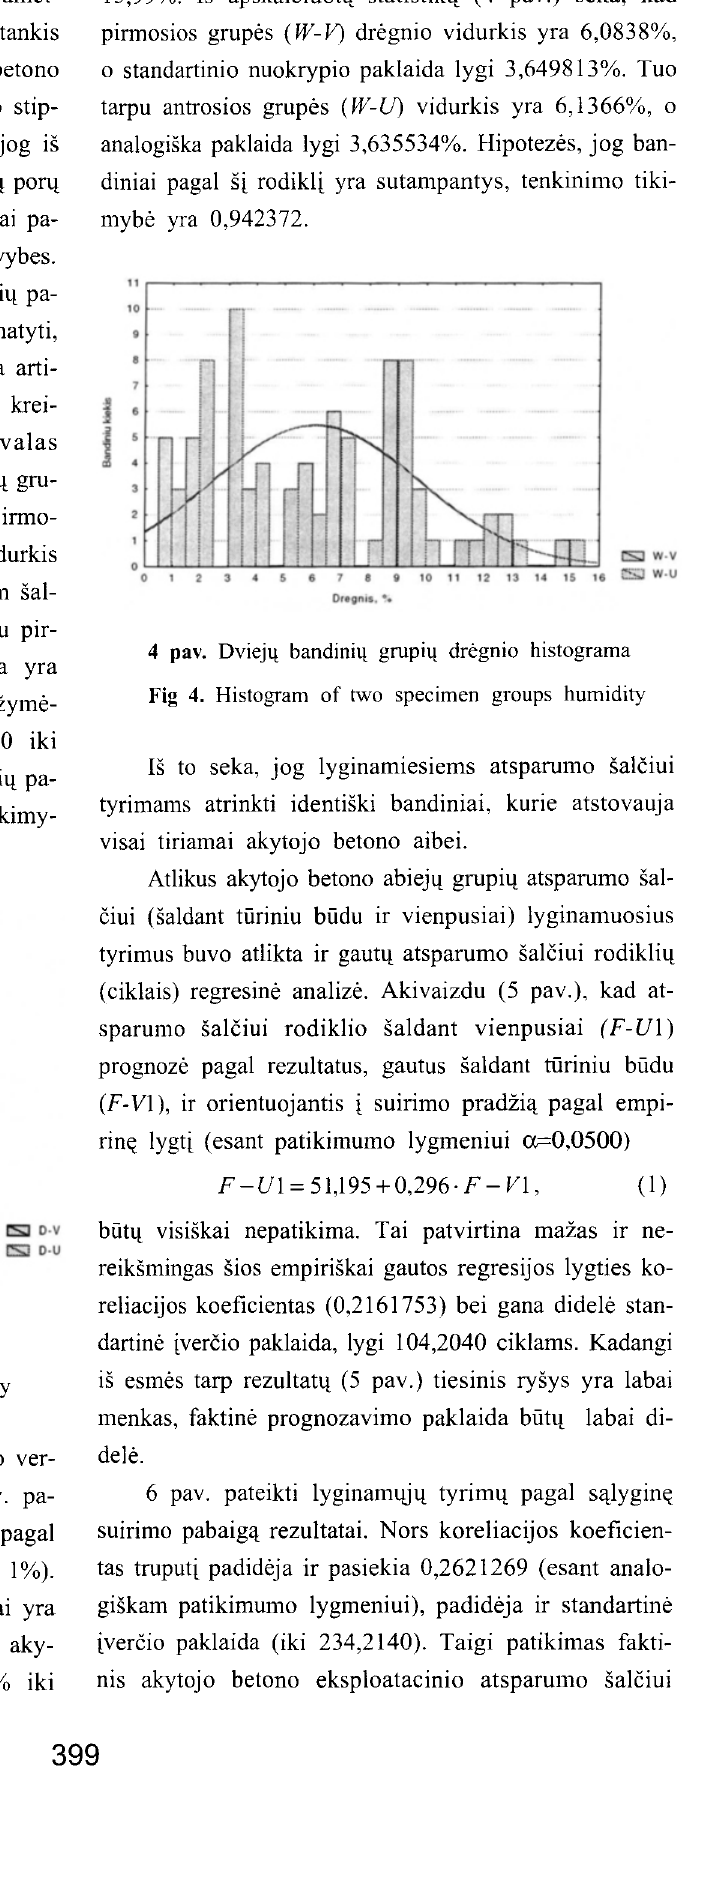
Fig 3. Histogram of two specimen groups density Nustatytos t4 paciq bandiniq dregnio rodik1io ver tes ir atlikta ana1ogiska statistine ana1ize. 4 pav. pa teiktas tq paci4 bandinitt grupi4 pasiskirstymo paga1 dregni grafinis paveiks1as (kai padalijimo interva1as 1 %). artimi normaliajam ir praktiskai sutampa. Rea1iai aky